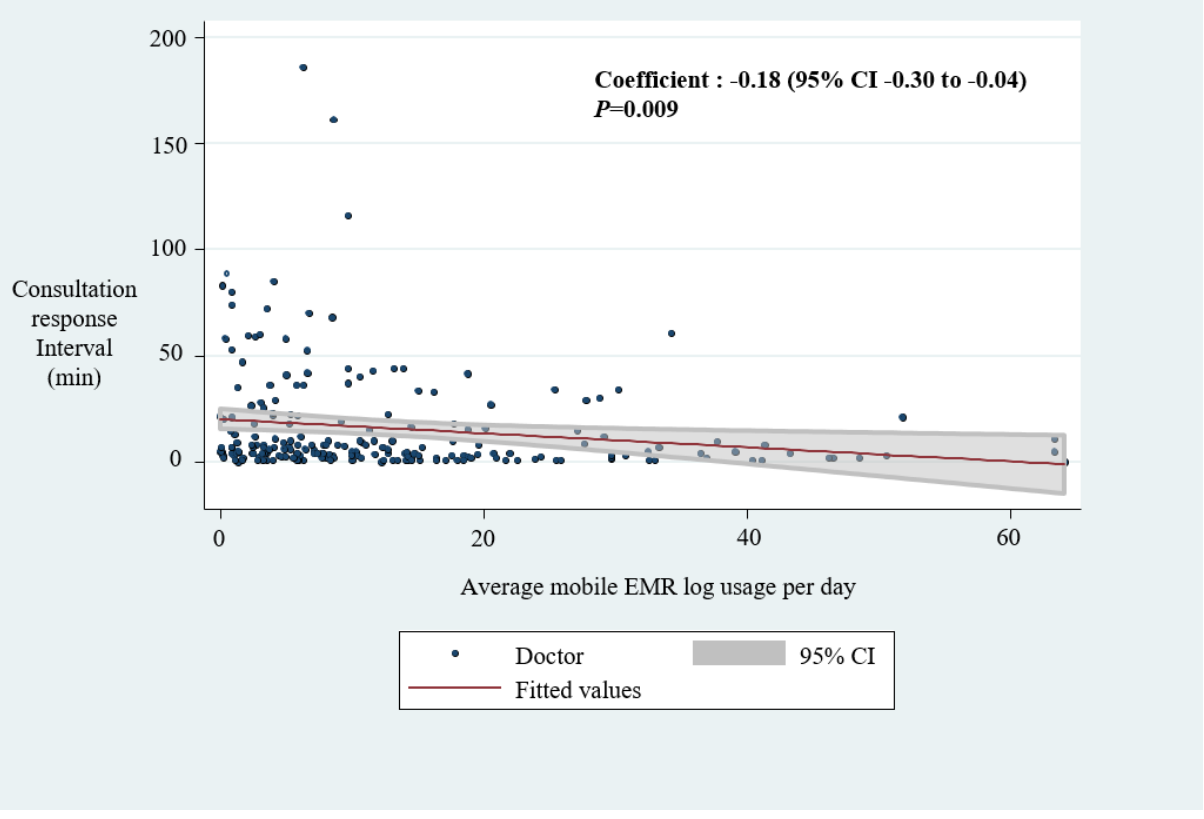
Figure 6. The correlation between consultation response interval and mobile electronic medical record frequency. EMR: electronic medical